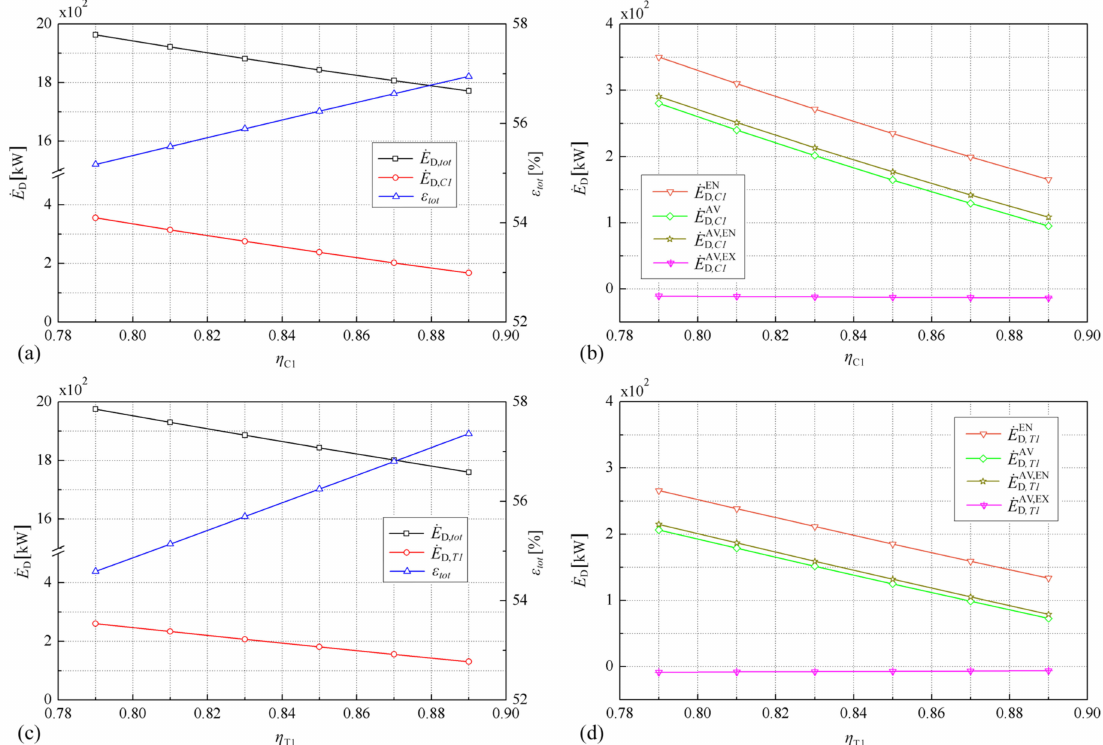
Figure 3. E ff ects of turbomachinery e ffi ciency: ( a ) conventional and ( b ) advanced exergy analysis results versus compressor 1 e ffi ciency; ( c ) conventional and ( d ) advanced exergy analysis results versus turbine 1 e ffi